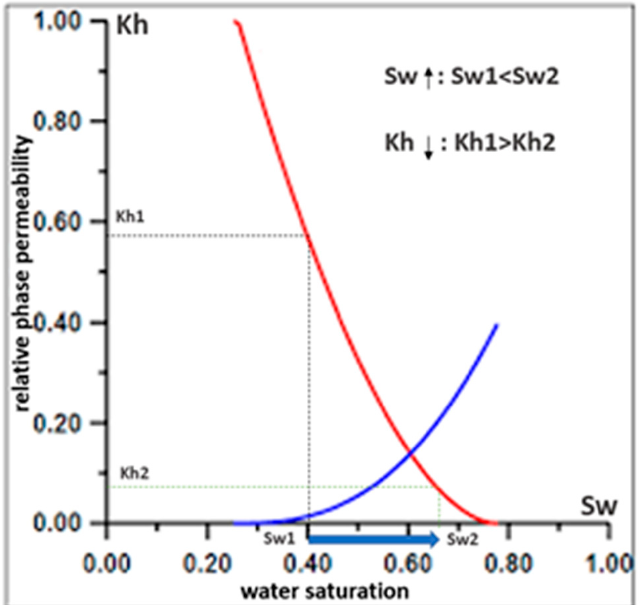
Figure 1. The effect of well water cut increase on sand production increase. Kh, relative phase permeability; Sw, water saturation.